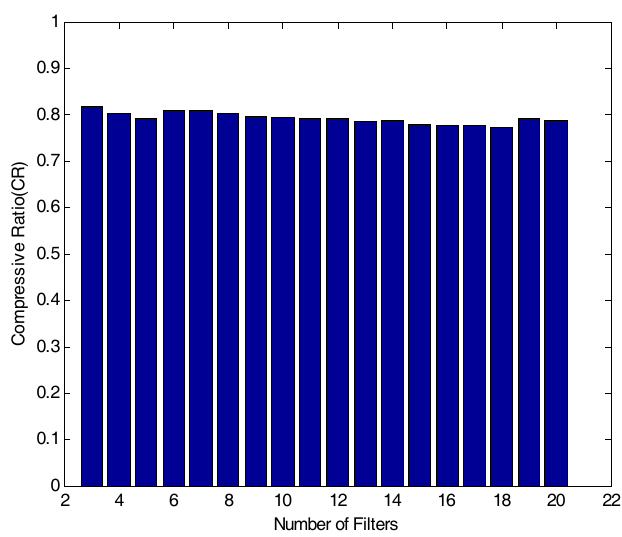
Figure 9. CR results for number of filters.